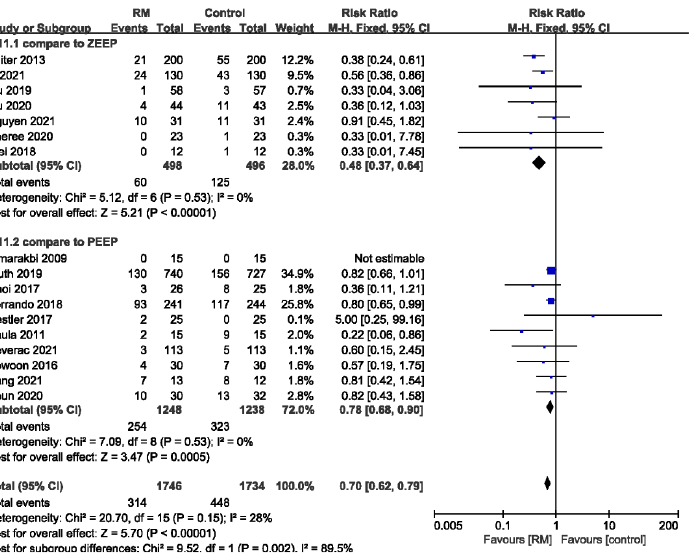
Figure 9. Forest plot for subgroup analysis of the incidence of PPCs between RM and control groups. Grouped by ZEEP or PEEP used in control group: compare to ZEEP, compare to PEEP [16 – 32].